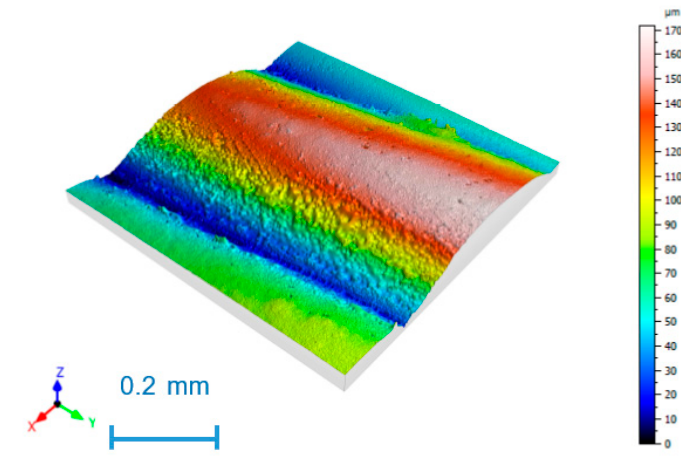
Figure 3. Surface topography for experiment 2.